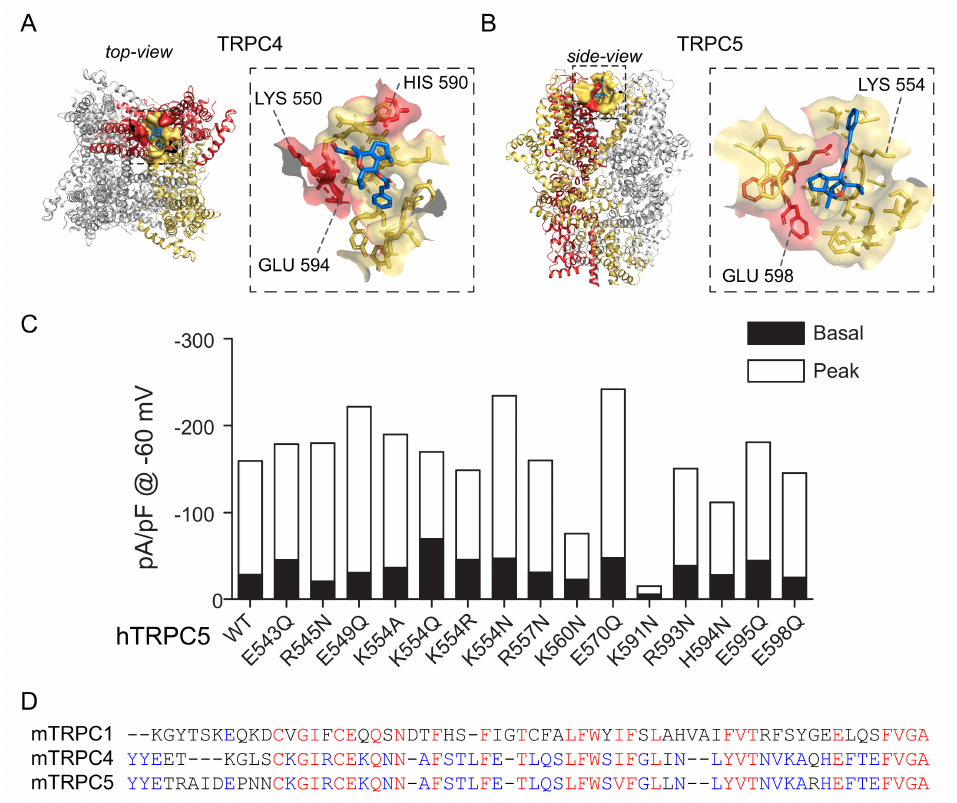
Figure 7. Binding models between Englerin-A and TRPC4, 5 channels. ( A ) Binding model for TRPC4. ( B ) Binding model for TRPC5. The model claims that not only the hydrogen bonding between hydroxyl group and polar residues but hydrophobic interaction is important in both cases. Yellow sticks, surfaces: subunit A; Red sticks, surfaces: subunit B; Blue sticks: Englerin-A ( C ) Electrophysiological recordings of TRPC5 with various point-mutations. Basal current of TRPC5 (black bar) and peak current (white bar) after extracellular application of 100 nM Englerin-A. ( D ) Sequence alignment of TRPC1, 4, and 5 channels along pore regions. TRPC1 shows significant di ff erence while the TRPC4 and 5 channel share great